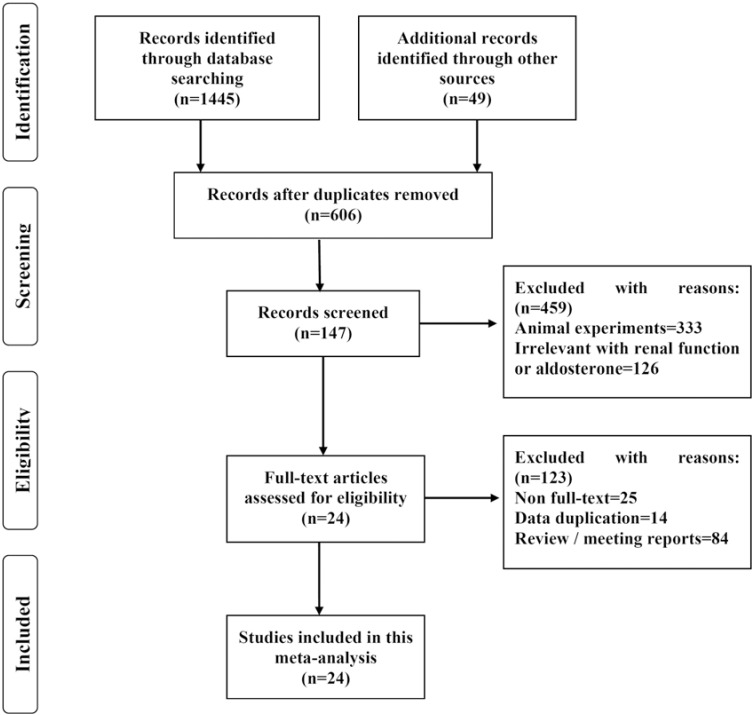
A schematic diagram of the search strategy for published reports.